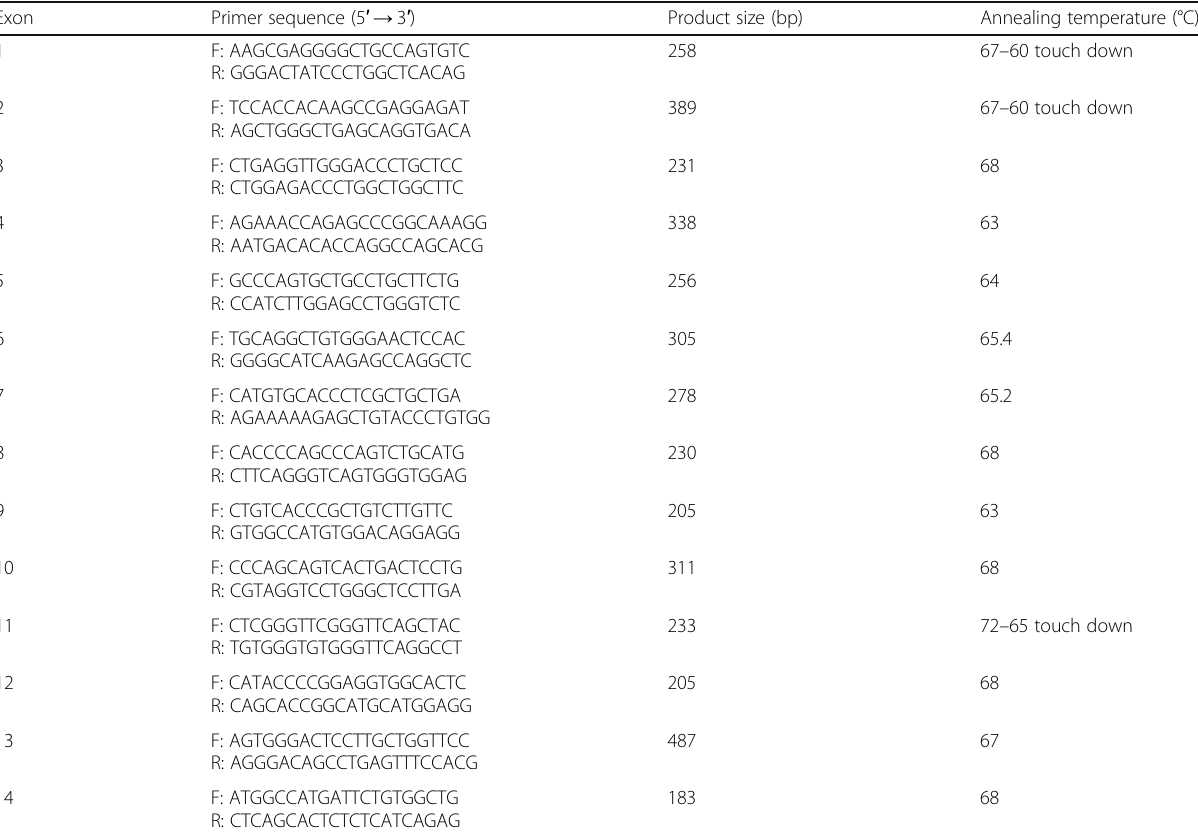
Table 2 Primer sequences and PCR conditions for the amplification of AIRE gene regions Exon Primer sequence (5 ′ → 3 ′ )